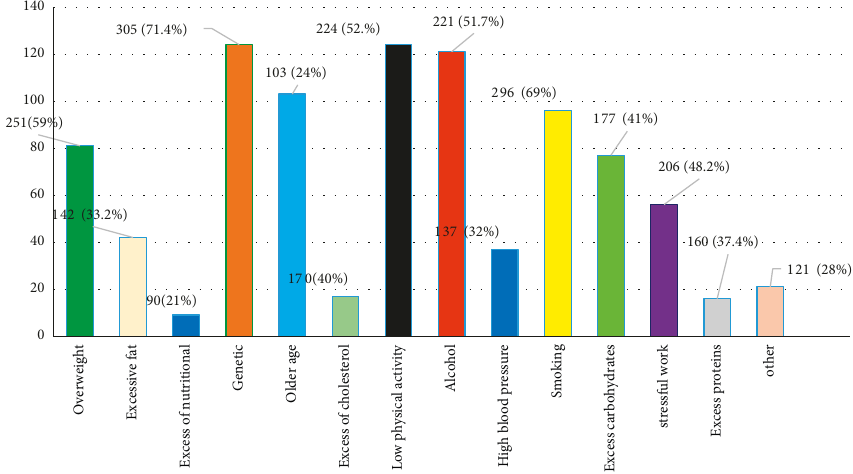
Figure 2: Risk factors associated with